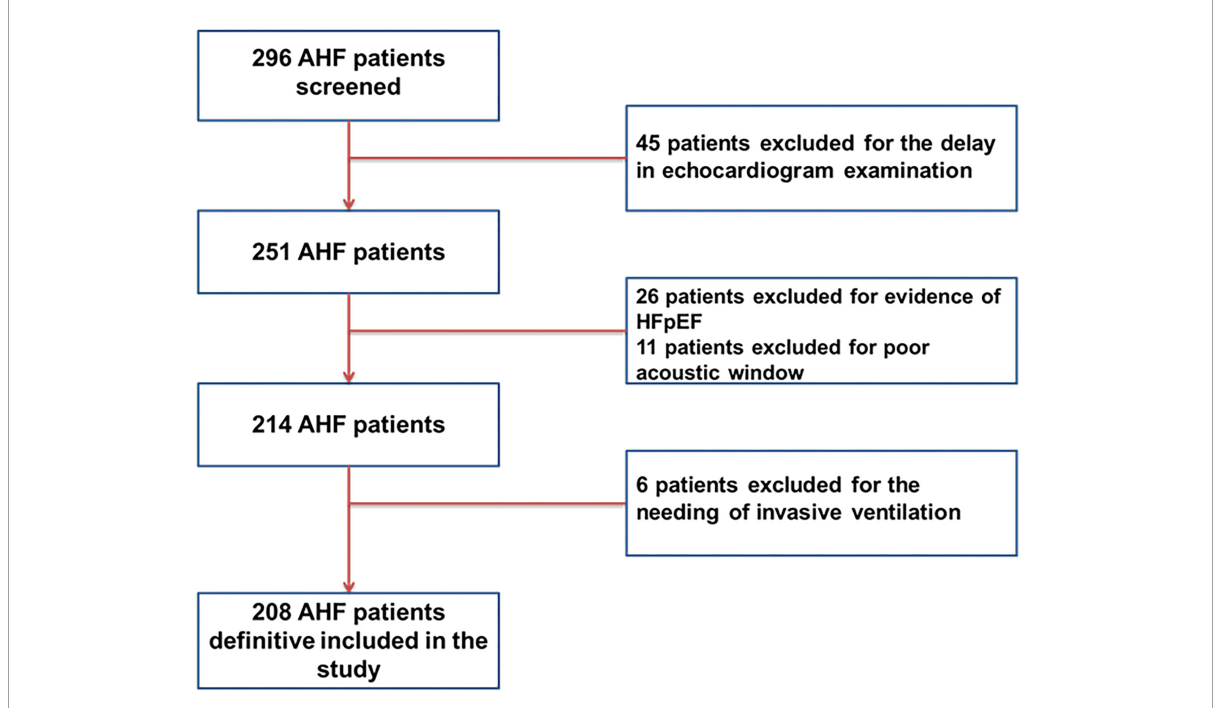
FIGURE1 Flow chart of the patients included in the study divided according to Stevenson